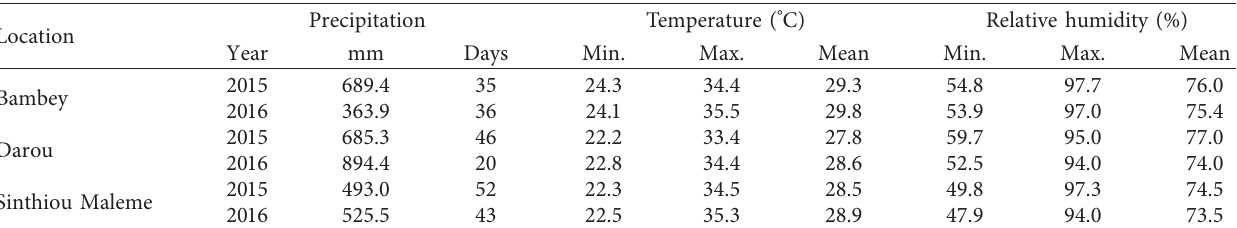
Figure 1: Map of Senegal showing the experimental locations, Darou � Darou-Pakathiar. Table 1: Precipitation, temperature, and relative humidity for Bambey, Darou, and Sinthiou Maleme during the growing seasons between July and October in 2015 and